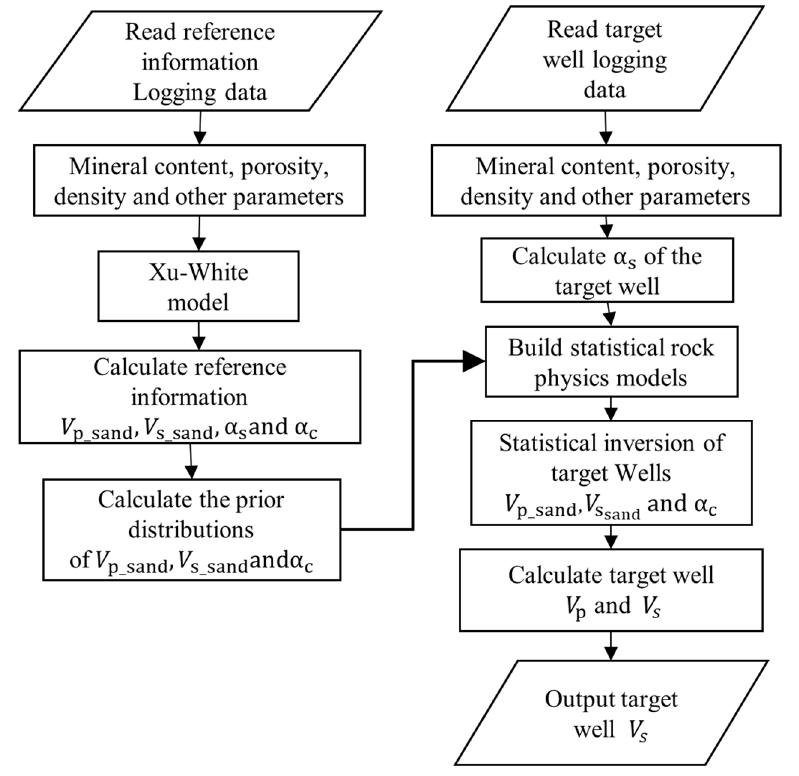
Figure 1. Work flow of the shear wave velocity prediction based on the improved Xu–White